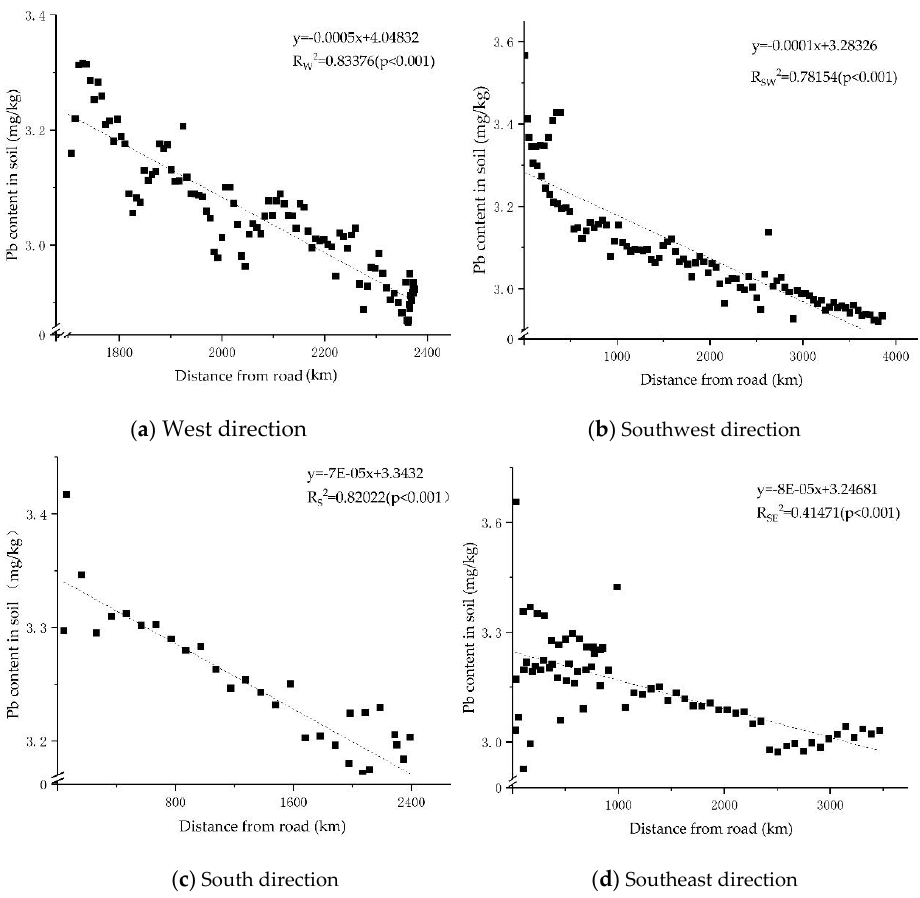
Figure 8. Regression diagram of Pb content in the soil of the mining area and distance from high- way. ( a )–( d ) are significant at the p < 0.001